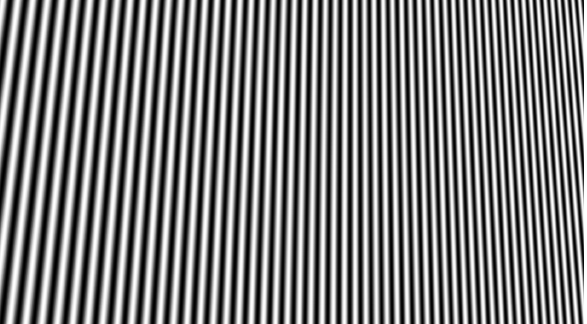
Figure 4. Virtually built reference image with sinusoidal fringes. Perspective affects frequency com-